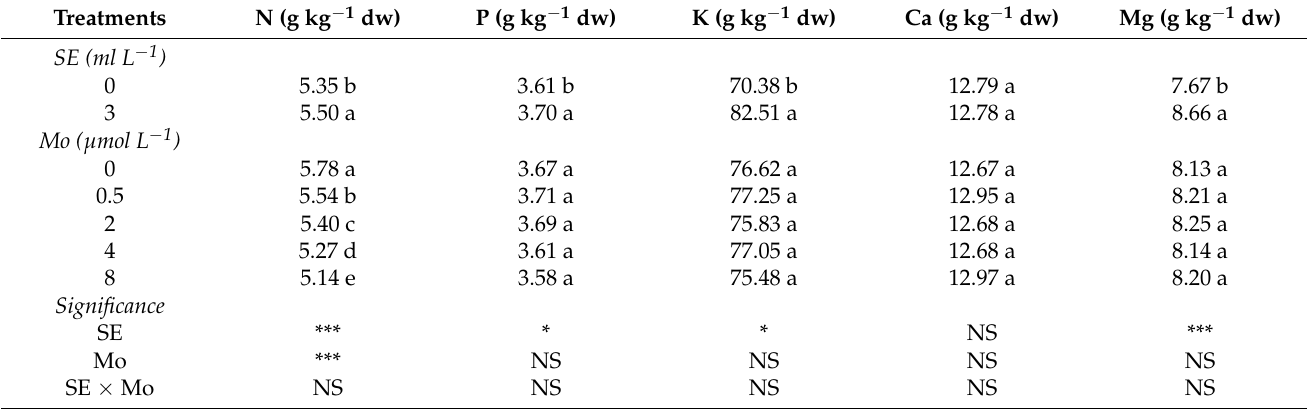
Table 3. Impact of SE application and Mo-biofortification on mineral profile (N, P, K, Ca and Mg) of spinach plants cultivated in a protected